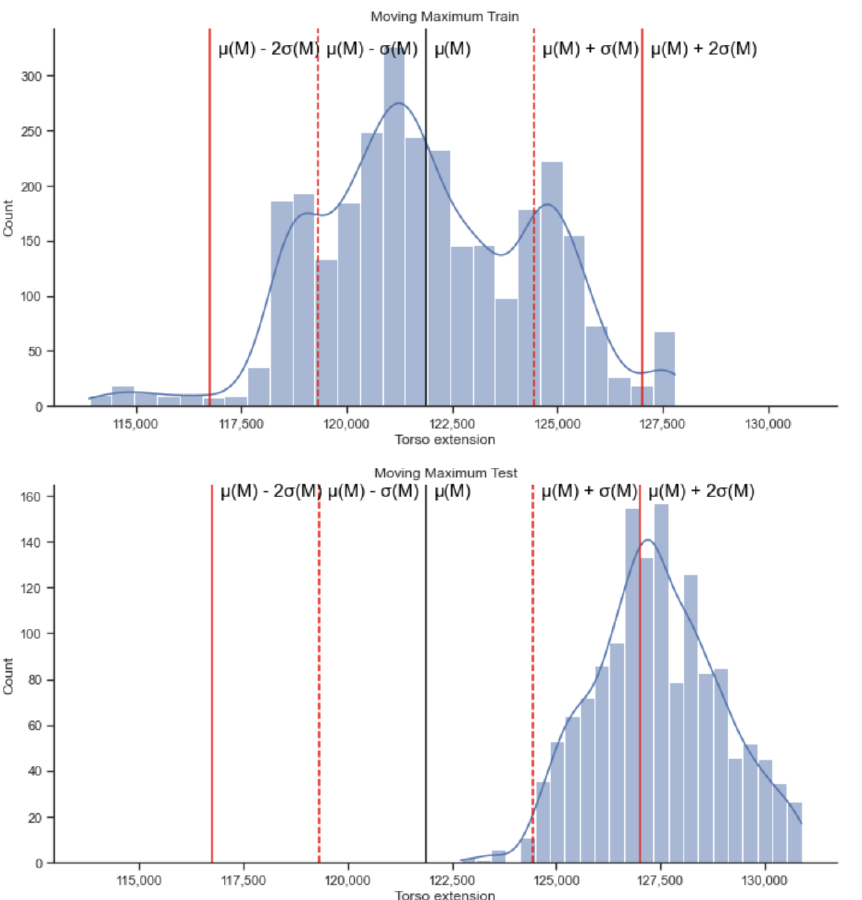
Figure 7. Distribution of training (sitting, walking) and testing values (running) for the moving maximum algorithm on the respiration signals for a participant on the combined data (talking and not